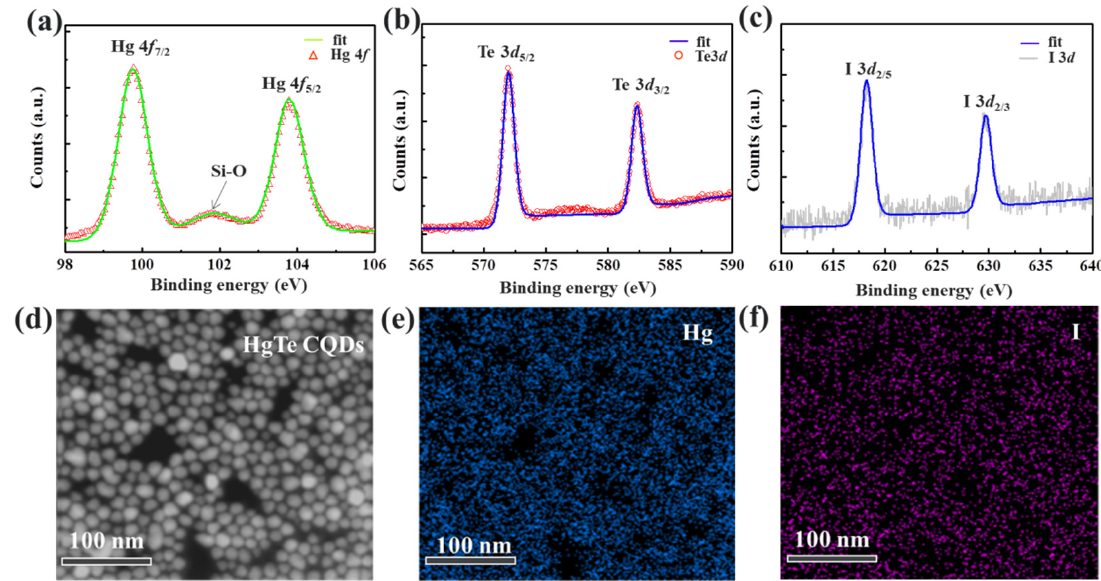
Figure 4. Hg 4 f ( a ), Te 3 d ( b ), I 3 d ( c ) XPS spectra of HgTe CQDs; EDX spectrum of HgTe CQDs, ( d ) electron image, ( e ) Hg element distribution map, ( f ) I element distribution map. Table 1. XPS results of different HgTe CQDs films.